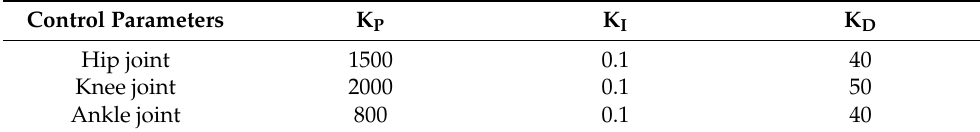
Table 3. PID parameters for each joint.